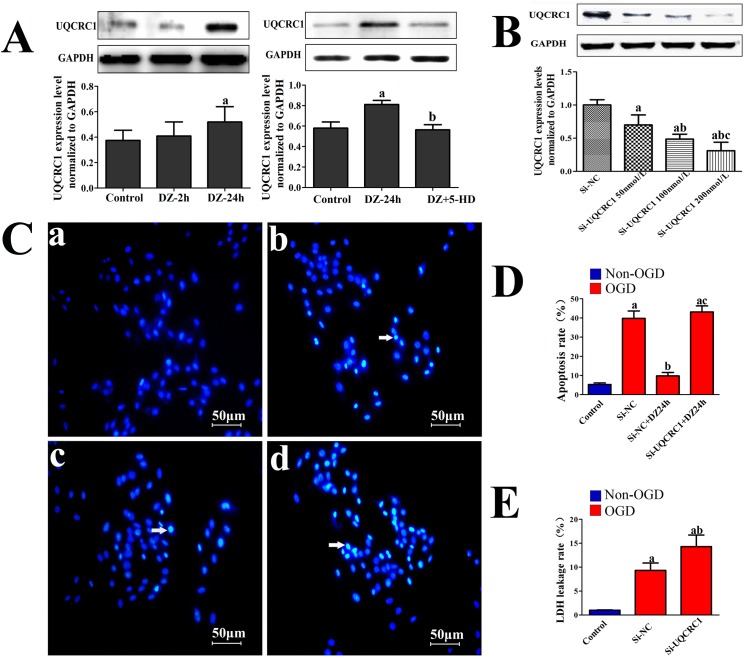
The effect of diazoxide treatment on UQCRC1 expression and the effects of UQCRC1down-regulation on apoptosis rate and LDH leakage rate after OGD in H9C2 cells.(A) Change in UQCRC1 expression after treatment with diazoxide or diazoxide combined with 5-HD (n = 8); (B) The effect of silencer sequence of siUQCRC1 on UQCRC1 expression levels in H9C2 cells (n = 6); (C) and (D) The effect of UQCRC1down-regulation on apoptosis rate of H9C2 cells after OGD (n = 5); (E) The effect of UQCRC1down-regulation on LDH leakage of H9C2 cells after OGD (n = 8). White arrow: apoptotic cell; Data were expressed as mean ± SD; a, P < 0.05, vs. first group; b, P < 0.05, vs. second group; c, P < 0.05, vs. third group.